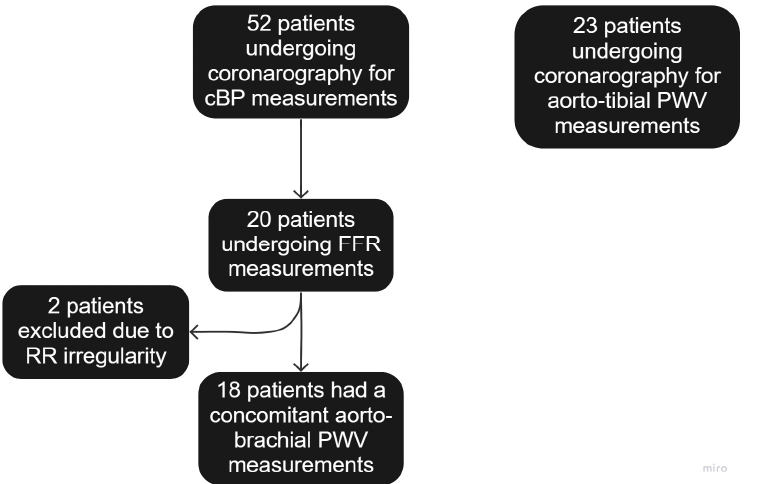
Figure 1. Flowchart of patients’ recruitment. Two patients with an FFR wire were excluded due to RR irregularity preventing PWV measurement.